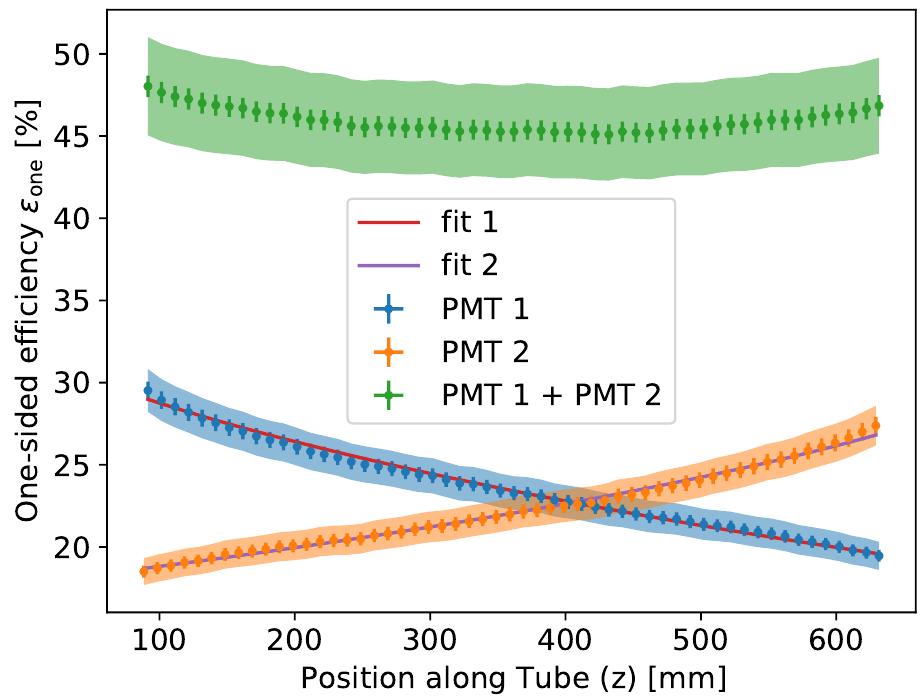
Figure 12. Efficiency as a function of the distance from the ends of the tube for a quartz tube [10]. The flattened model efficiency is used as a fit function to extract attenuation lengths. The injected light has a wavelength of ( 375.00 ± 1.06 ) nm. Systematic errors are shown as shaded